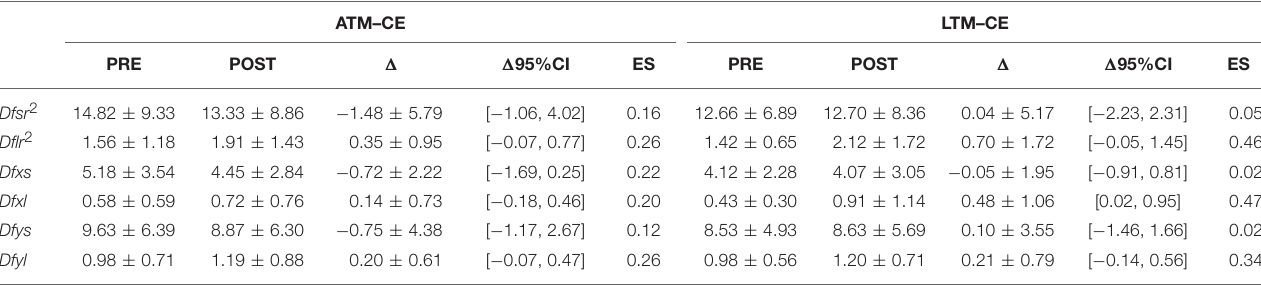
TABLE 4 | Stabilogram diffusion analysis results in the CE condition.